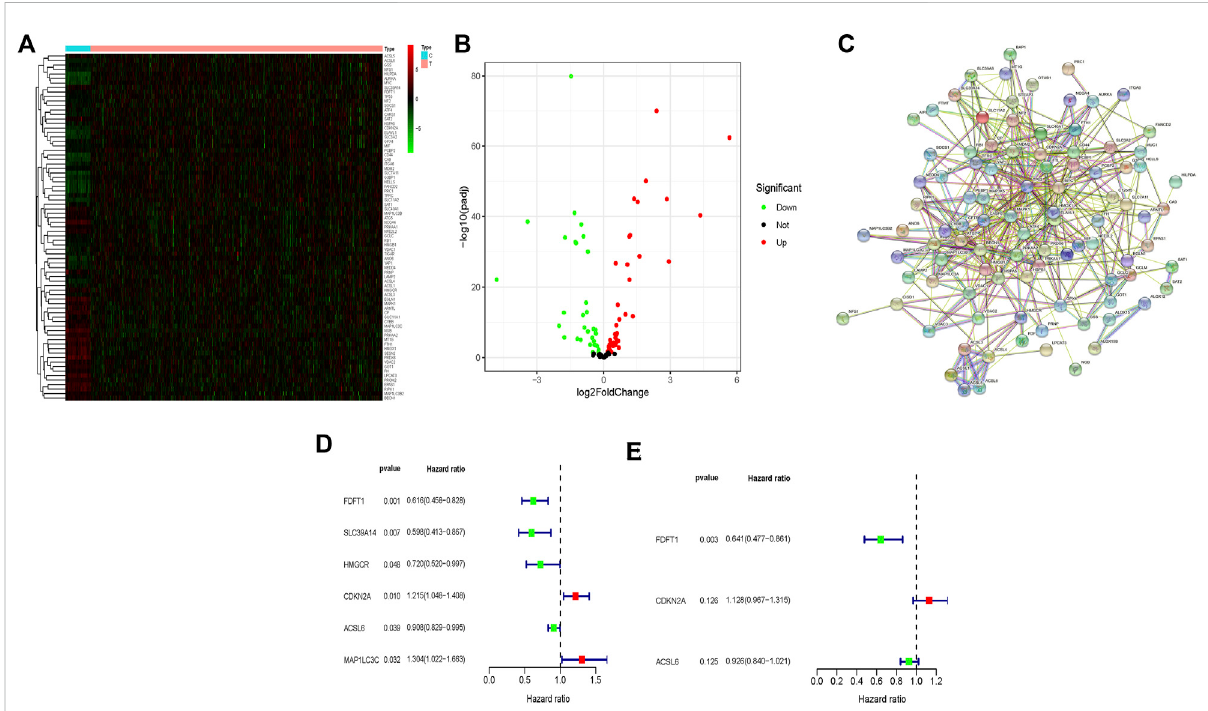
FIGURE 1 Identi fi cationofdifferentexpressionallevelsofferroptosis-associatedgenesandtheirprognosticsigni fi canceinCRC. (A) Differentexpressional levels of ferroptosis-associated genes in TCGA cohort were displayed in the heatmap and (B) the volcano map; (C) PPI network indicated the interactions among the candidate genes from the STRING; (D,E) a ferroptosis-associated gene signature was constructed by using univariate and multivariate Cox regression analyses to exert a predictive effect on the prognosis of